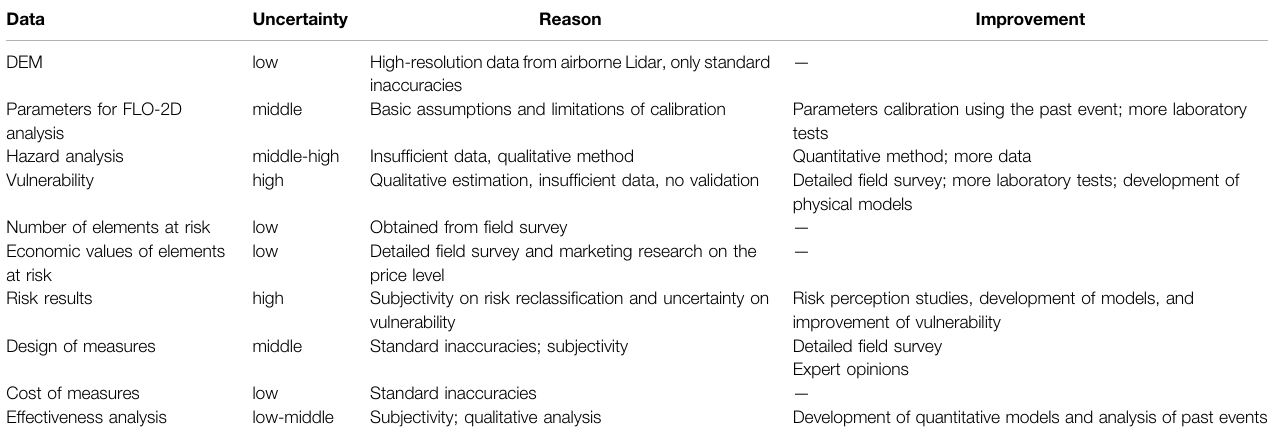
TABLE 6 | Uncertainty analysis for input